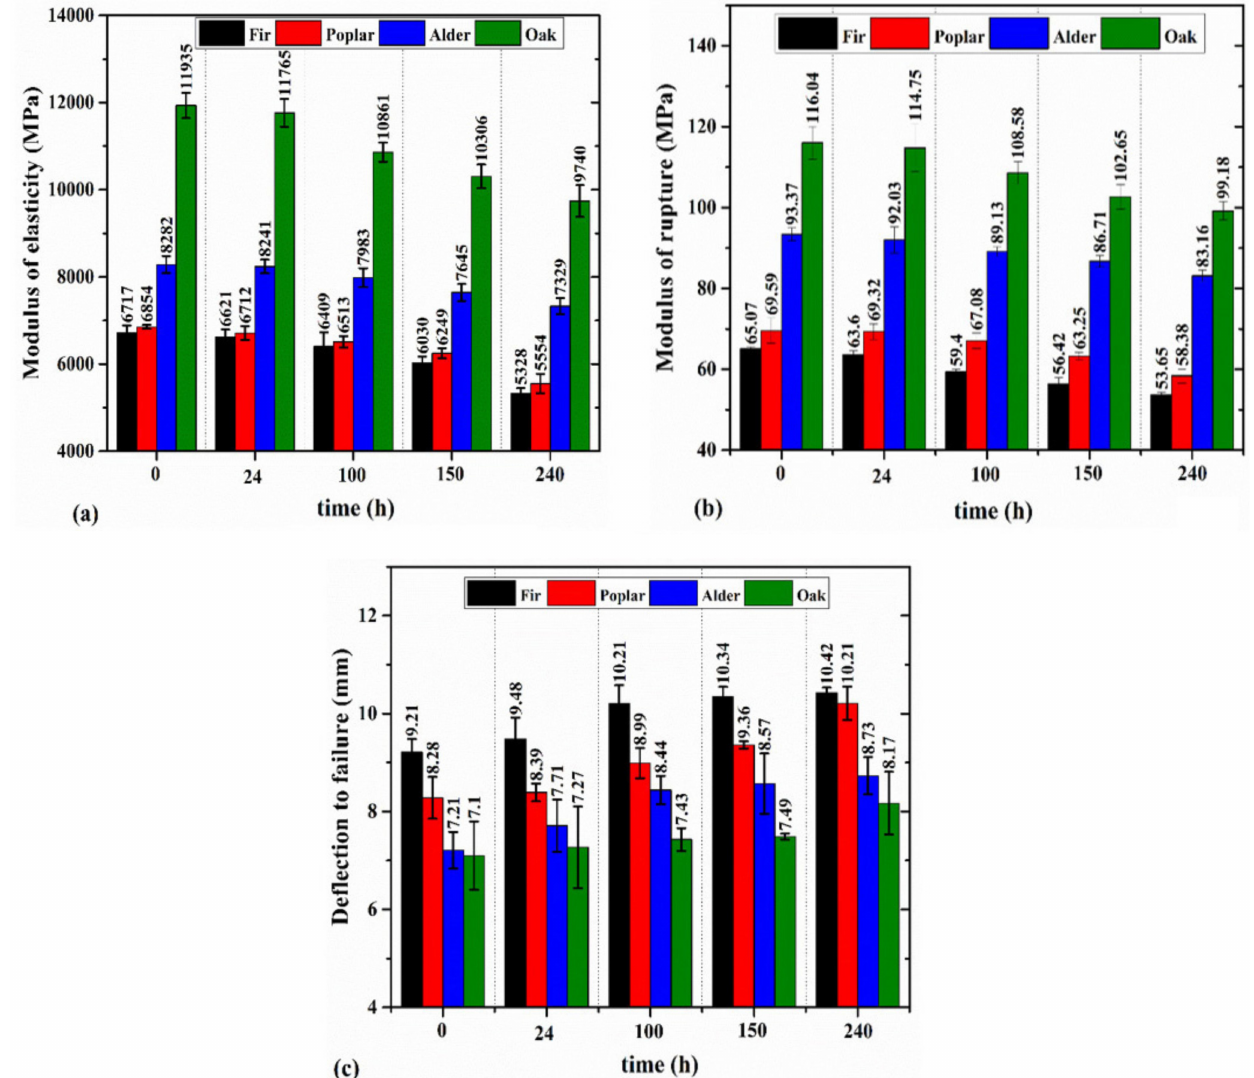
Figure 3. The variation of MOE ( a ), MOR ( b ), and deflection to failure ( c ) in weathered wood